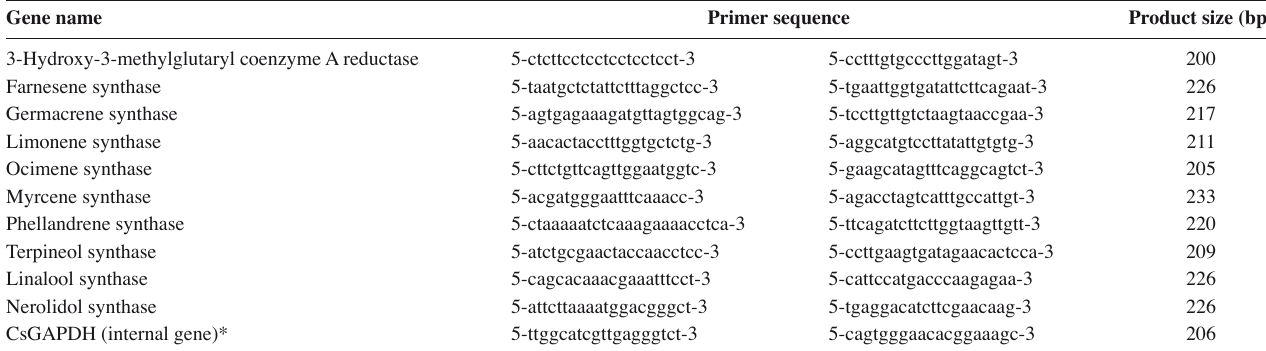
Tab. 2: The q RT-PCR primers of terpenoid synthase genes in tea tree leaves Gene